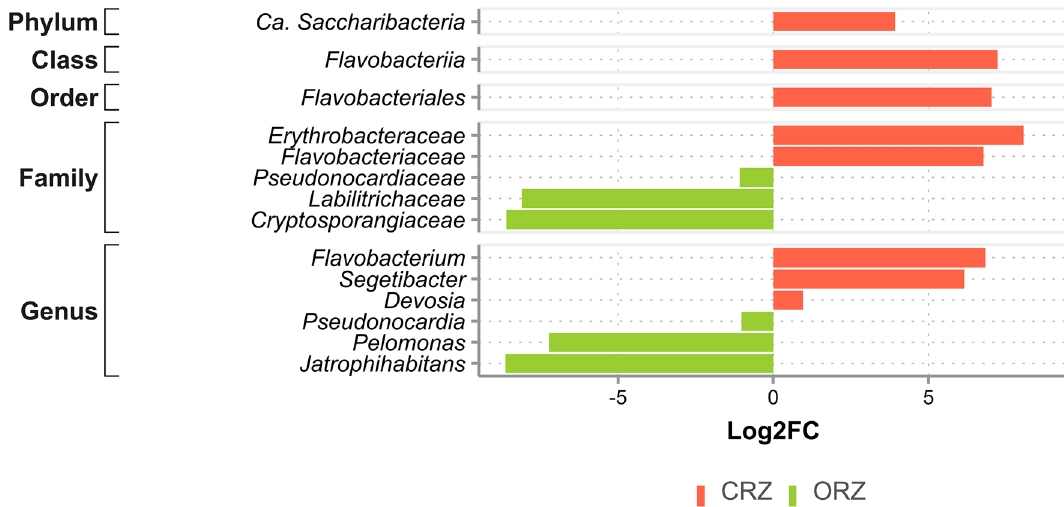
Figure 8. Differently abundant prokaryotic taxa between conventional (CRZ) and organic (ORZ) farming systems present in the sugarcane rhizosphere microbiota, through statistical verification by the Wald test, considering a p -value ≤